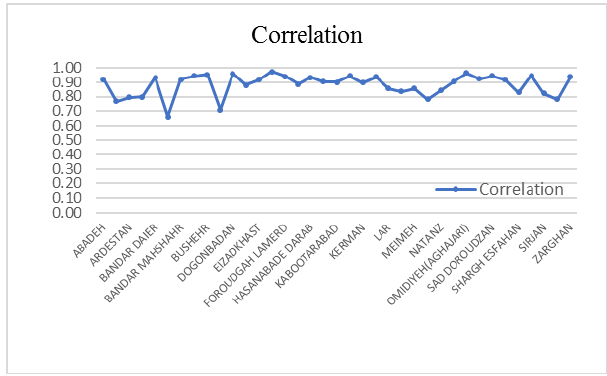
Figure 2. Correlation of precipitation product and rain